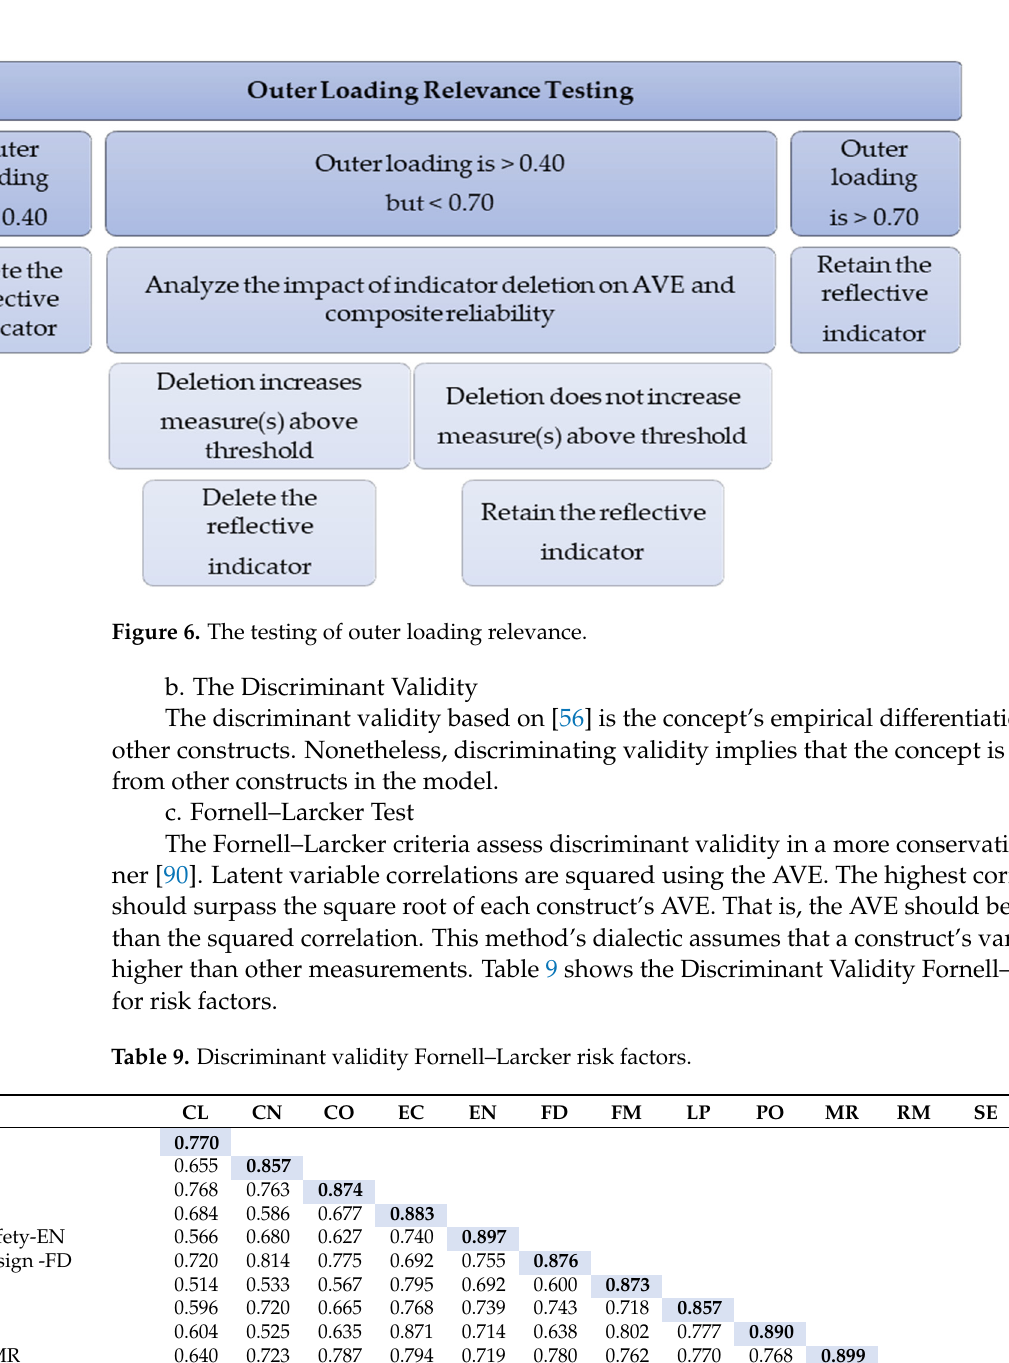
Figure 5. AVE and Factor Loading Analysis.